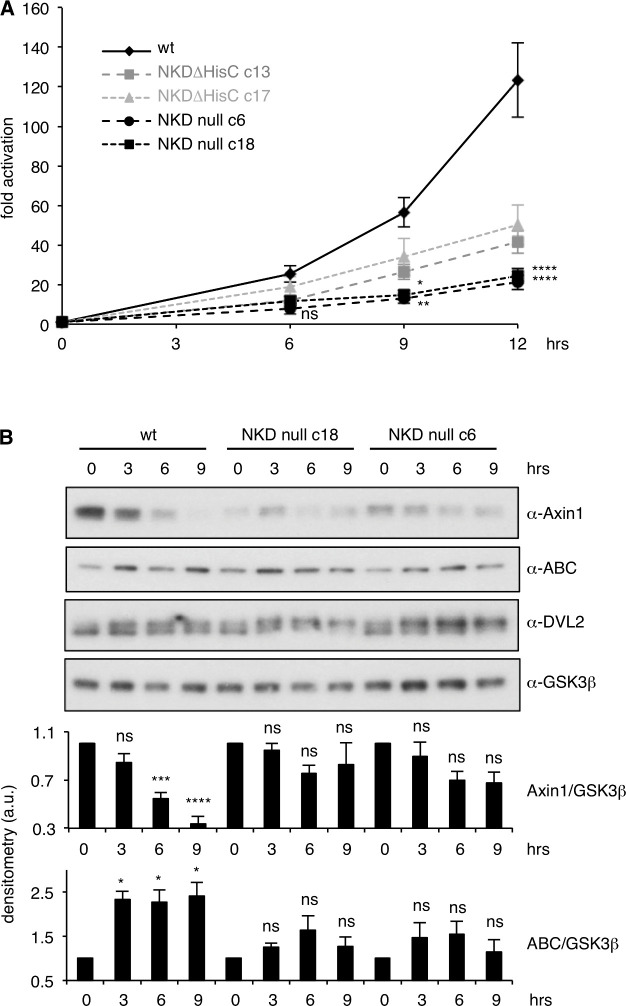
NKD is required for sustained Wnt signaling.(A) Western blots corresponding to SuperTOP assays shown in main Figure 5A, monitoring expression levels of endogenous proteins in NKD null cells, quantified by densitometry underneath, normalized to 0 hr time point for each cell line (A.U., arbitrary units); SEM of >3 independent experiments; two-way ANOVA with multiple comparisons; *p < 0.05, ***p < 0.001, ****p < 0.0001; ns = not significant. We note that the levels of endogenous Axin1 are consistently reduced in unstimulated NKD null cells compared to their parental controls, perhaps reflecting a compensatory mechanism of these null cells to maximize their tonic Wnt signaling levels (see also Gammons et al., 2016b).